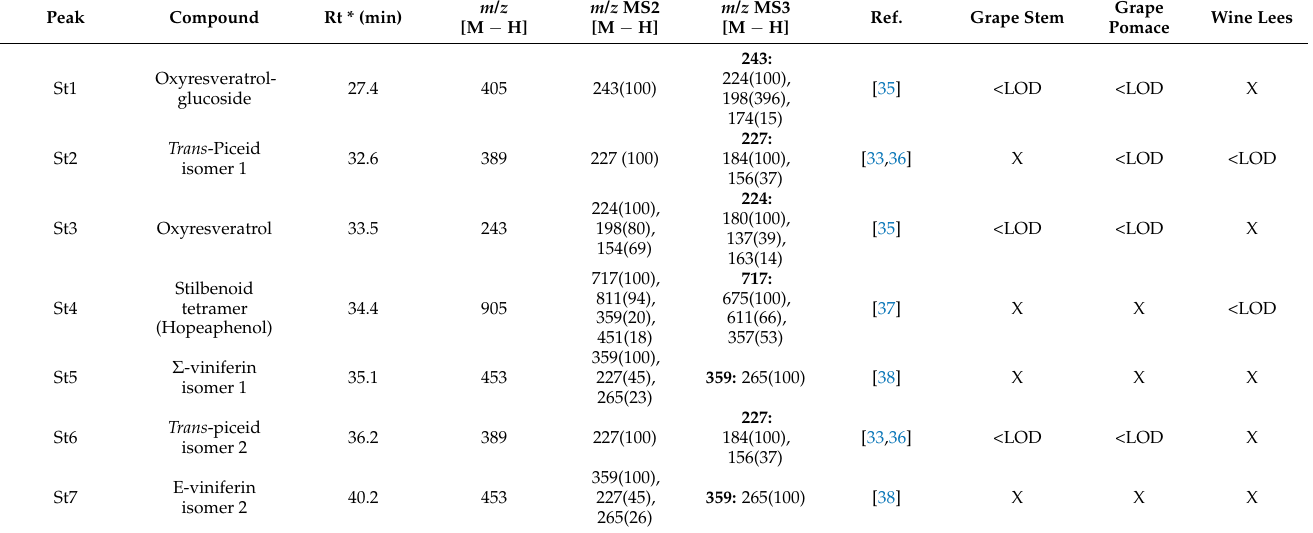
Table 3. Identification of stilbenes in grape ( Vitis vinifera L. var. ’Monastrell’) stem and pomace, as well as wine lees by HPLC-PDA-ESI-MSn operating in negative